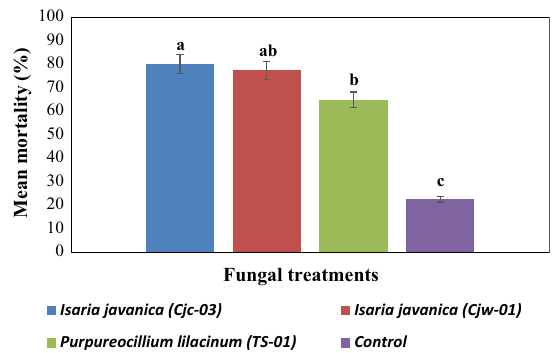
Fig. 7 Mortality of adult Bemisia tabaci at 7 DAT when treated with Isaria javanica (Cjc-03, Cjw-01) and Purpureocillium lilacinum (TS-01) at 1 10 7 conidia/ml concentration. Different letters above the bars × indicate statistical significance ( p < 0.05, LSD test)